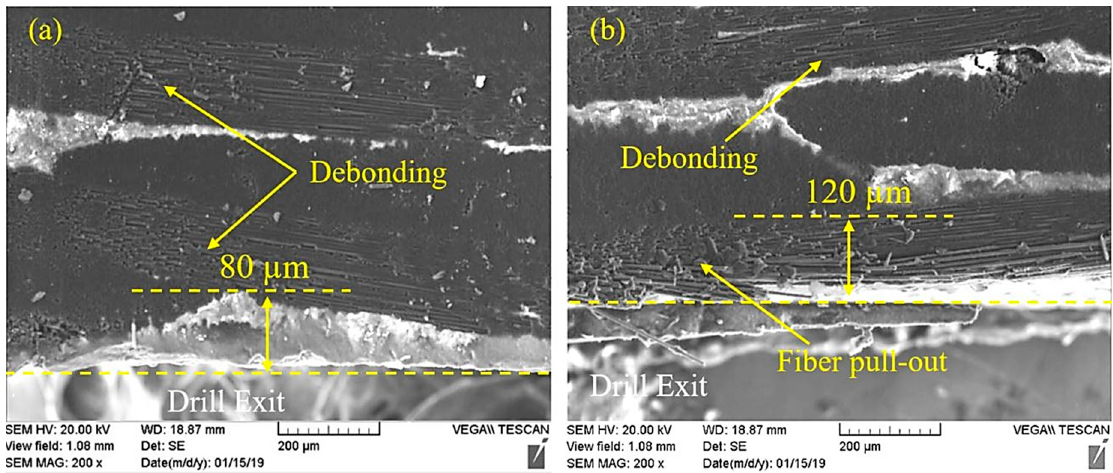
Figure 14. The scanning electron microscopic (SEM) examination of LF-VAD machined hole at f = 0.075 mm/rev and N = 3000 rpm on the exit surface for ( a ) A m = 0.07 mm and ( b ) A m = 0.48 mm.